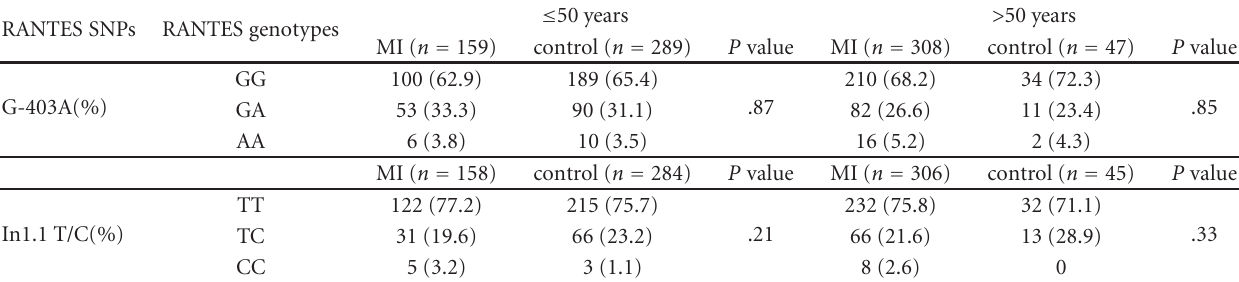
Table 3: RANTES genotype frequencies in MI patients and cases subdivided according to age at the first MI episode. RANTES SNPs